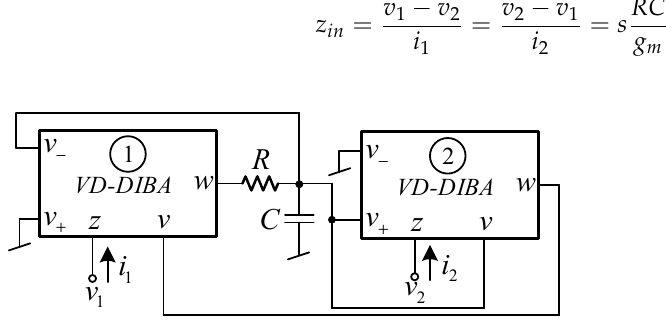
Figure 14. The floating lossless inductance simulator based on VD-DIBAs.